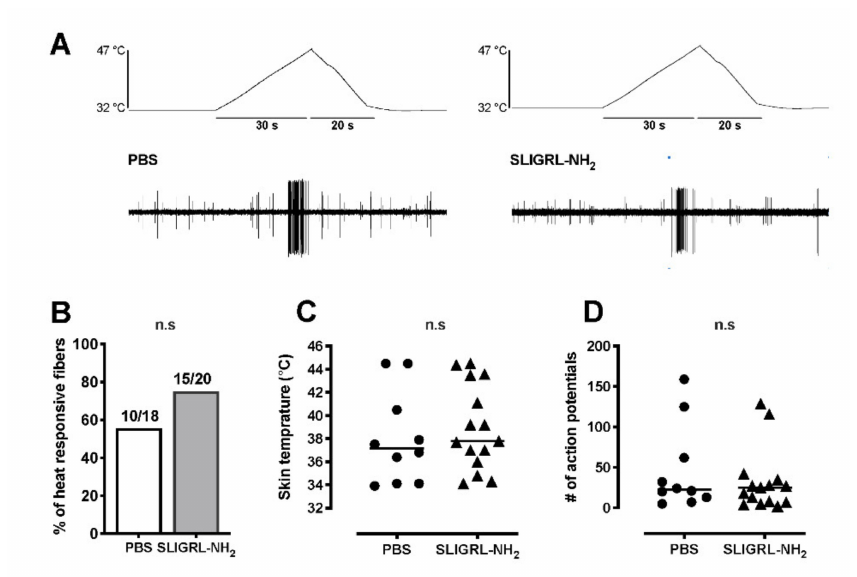
Figure 4. Effects of PAR-2 agonist SLIGRL-NH 2 on heat responses of mechanonociceptive C-fibers. ( A ) Example recordings of C-fibers after application of either PBS-vehicle or 100 µ M SLIGRL-NH 2 . Each fiber was tested with one application, either PBS or SLIGRL-NH 2 . ( B ) Proportion of C-fibers responsive to heat after application of SLIGRL-NH 2 or PBS-vehicle. ( C , D ) Heat responses of C-fibers after exposure to SLIGRL-NH 2 or PBS-vehicle. Heat thresholds ( C ) and total action potentials for 50 s during heat application ( D ). Each symbol represents a single